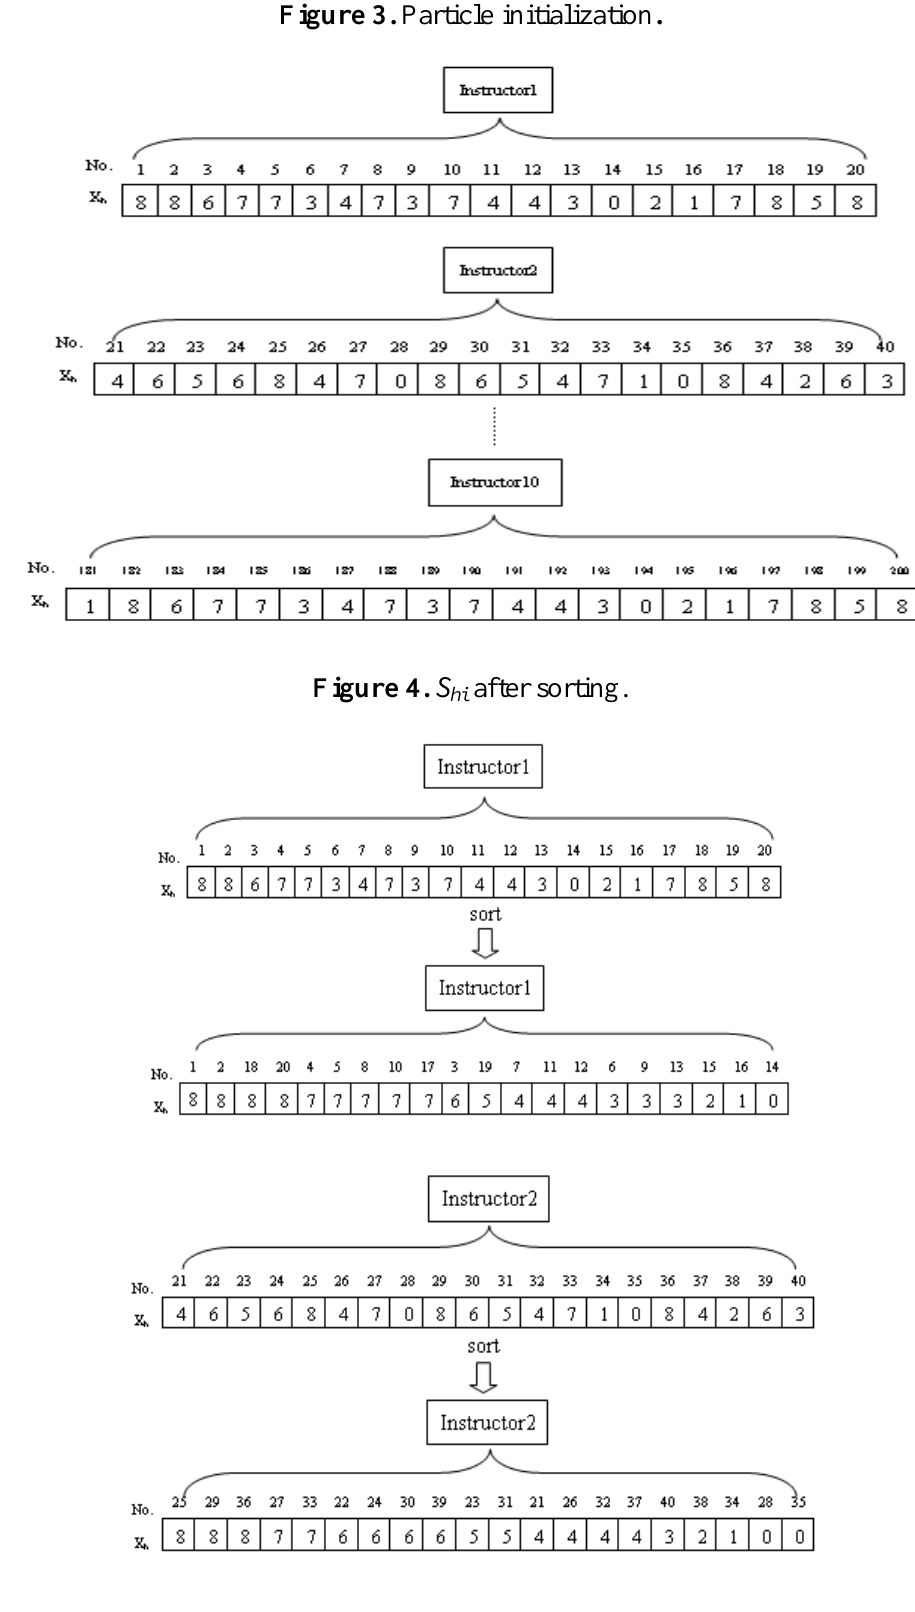
Figure 3. Particle initialization .